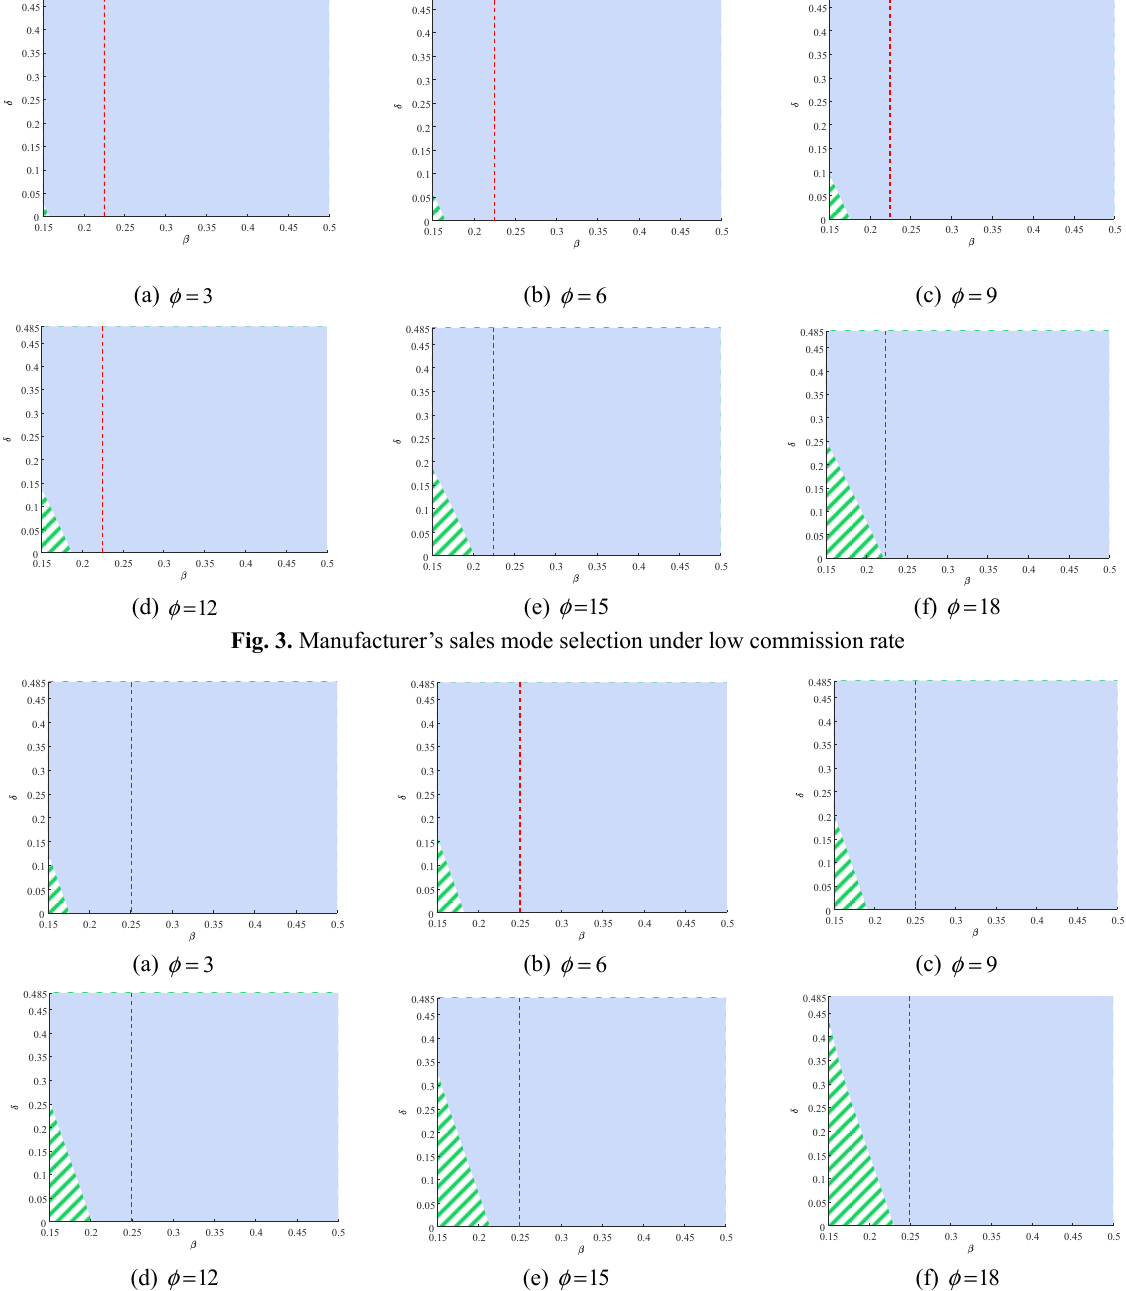
Fig. 4. Manufacturer’s sales mode selection under moderate commission